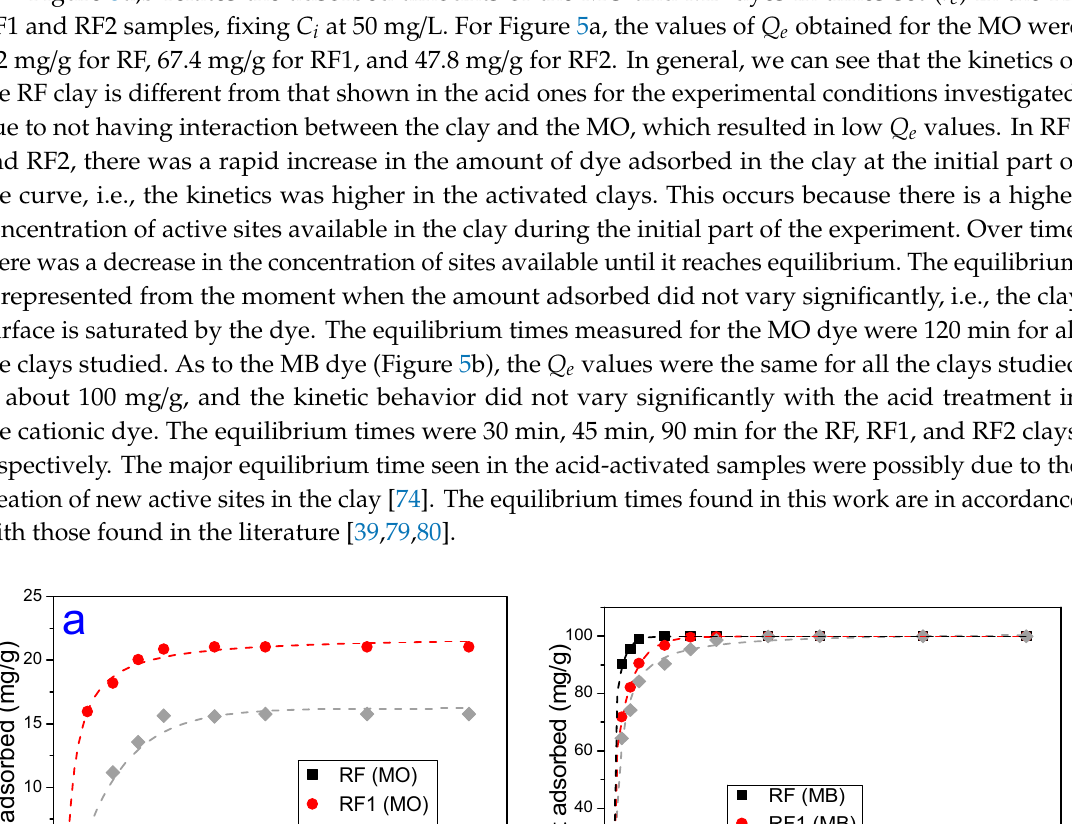
Figure 6. Adsorption isotherms of MO in room temperature conditions, adsorbent mass 100 mg, fixating (cid:1872) (cid:3030) in 120 min.